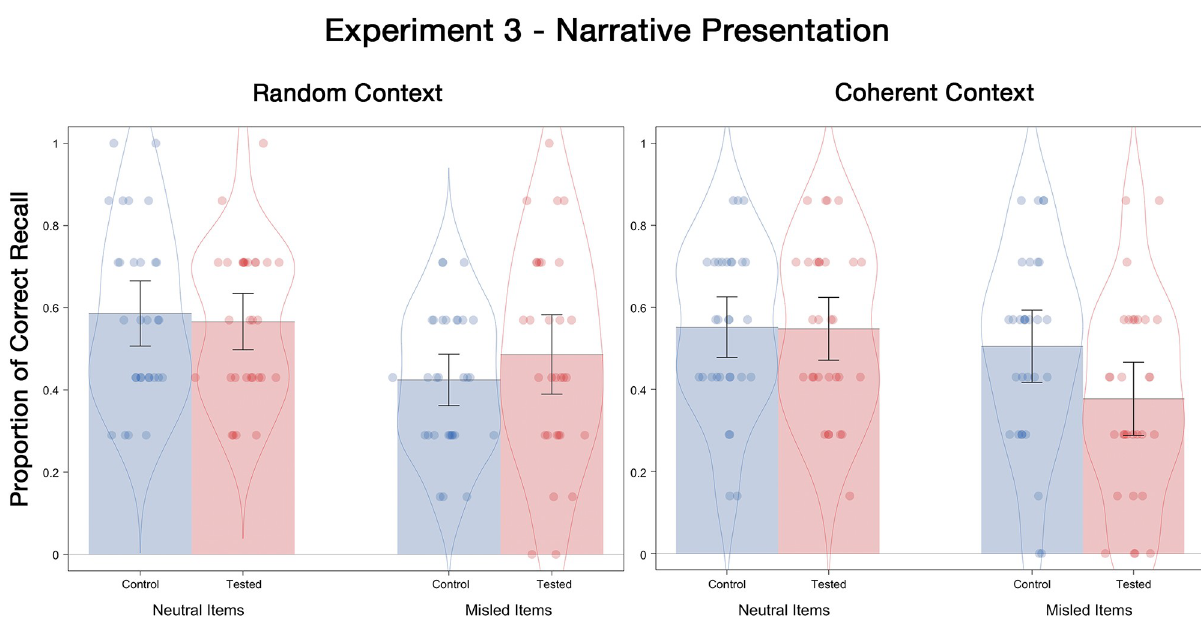
Fig 5. Correct recall probabilities for neutral and misled items as a function of the presentation order of context details on the final test of Experiment 3. Error bars indicate descriptive 95% confidence intervals. https://doi.org/10.1371/journal.pone.0212592.g005 = .04, such that testing did not affect spontaneous misinformation recall of the neutral ƞ 2 p items ( M = .05 for both control and tested), but it produced an RES effect for the misled items, ( M = .35 for tested and M = .25 for control). Lastly, the interaction between testing and con- text-order was marginally significant, F (1, 116) = 3.55, p = .06, ƞ 2